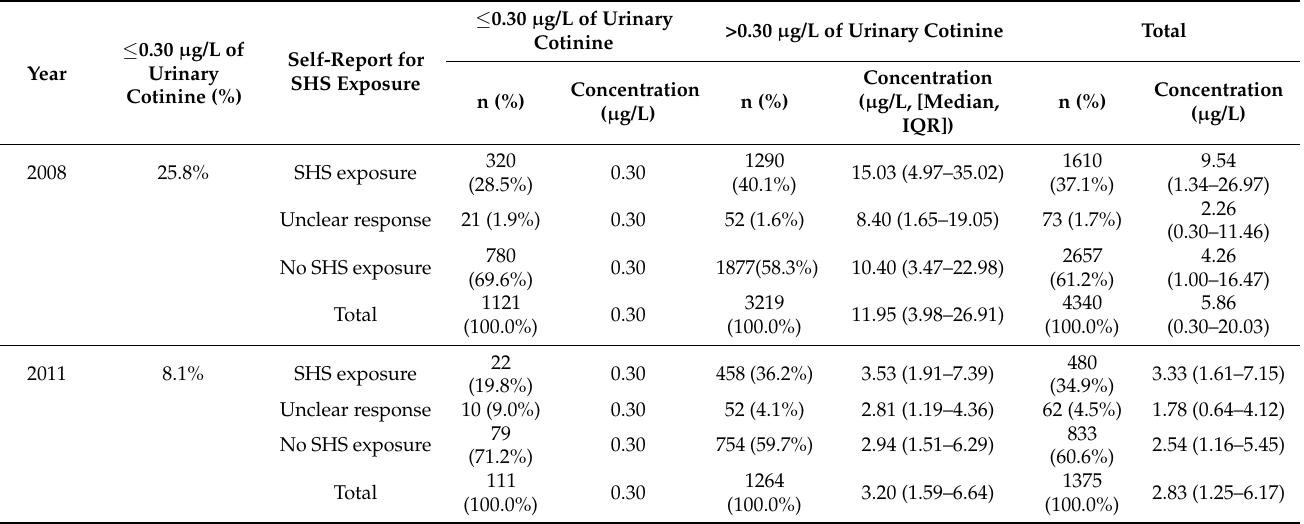
Table 3. The comparison between self-report for SHS exposure and urinary cotinine value in non-